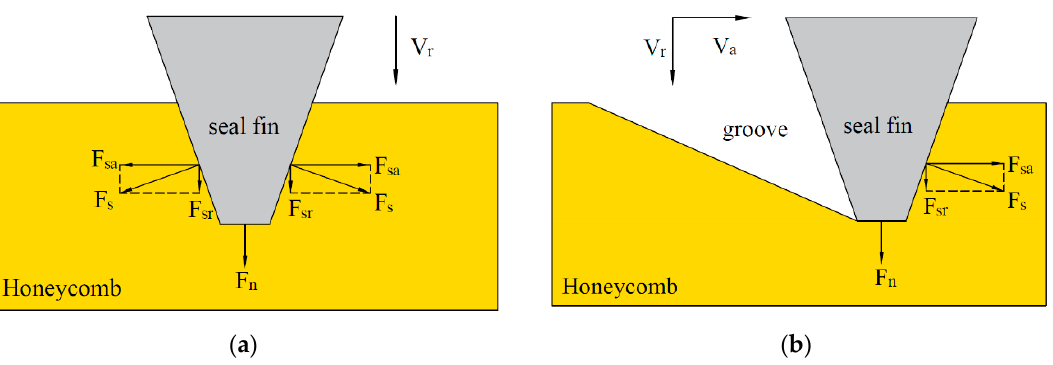
Figure 15. The generation of the rubbing forces; ( a ) radial rub; ( b ) radial rub and axial rub. According to the worn surface morphology and cross-sectional morphology and EDS results, the wear mechanism of the seal fin at different axial incursion rates can be analyzed. On axial rub side of the seal fin, there is no tribo-layer which indicates that the metal wear is the dominated wear mechanism. On the top surface of the seal fin, the worn surface presents the delamination of the tribo-layer. Hence, the delamination wear is the dominated wear mechanism. The participation of the axial rub does not change the wear mechanism.